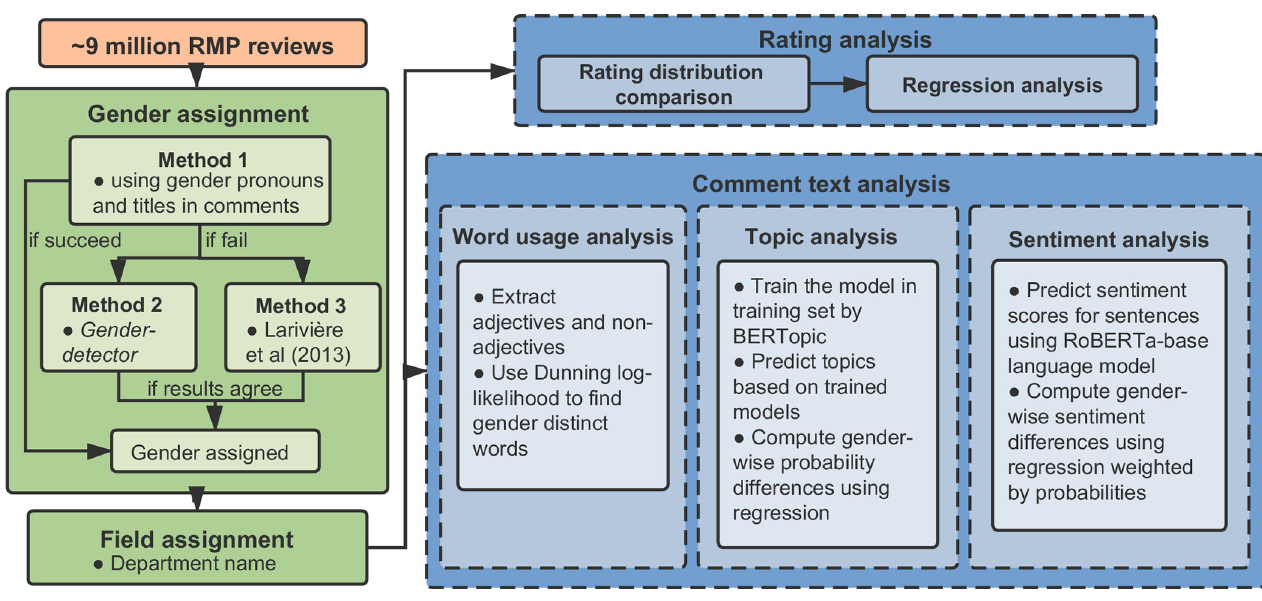
Fig 1. Overview of research design and